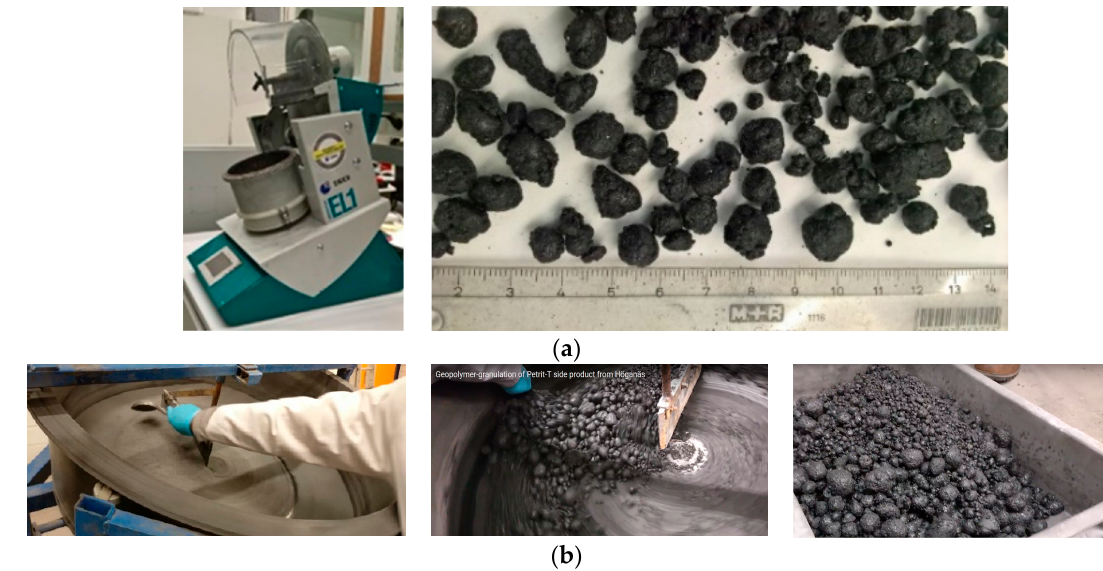
Figure 1. Granulation of Petrit-T to produce recycled aggregates at the ( a ) laboratory scale, and ( b ) pilot scale.